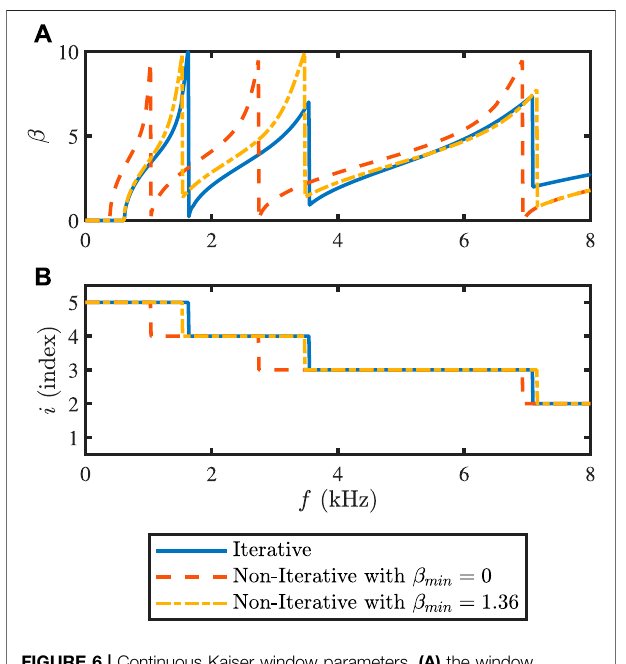
FIGURE 6 | Continuous Kaiser window parameters, (A) the window shape factor, and (B) the index ofthe window support from the set 2 x i { } 5 i (cid:2) 1 , as a function of frequency: iterative (solid line), non-iterative with β min =0 (dashed line), and non-iterative with β min =1.36 (dash-dot line).